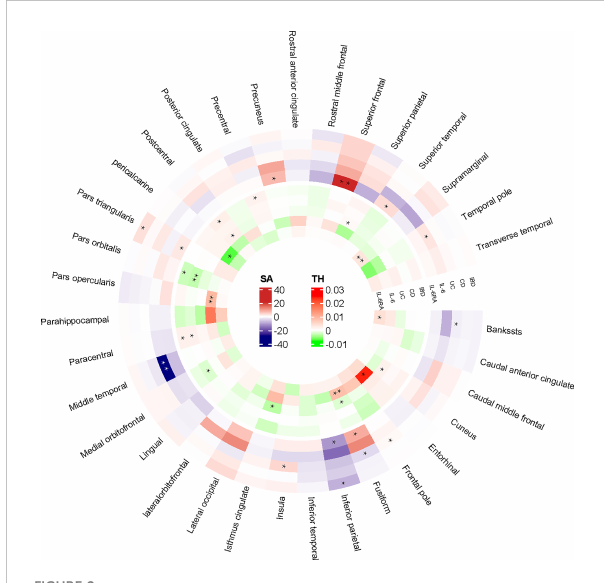
FIGURE 2 IVW-estimated effect values for altered cortical structures in 34 brain regions. “ ** ” referred to the signi fi cant results from Mendelian Randomization analysis. “ * ” de fi ned as the nominal signi fi cant results from Mendelian Randomization analysis. IBD, in fl ammatory bowel disease; CD, Crohn ’ s disease; UC, Ulcerative colitis; IL-6, interleukin 6; IL-6R a , interleukin-6 receptor subunit alpha; SA, surface area; TH,